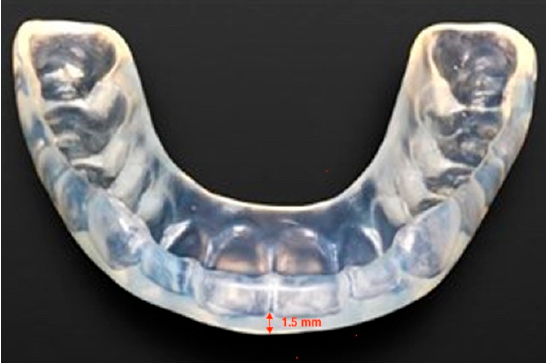
Figure 1. Individualized 1.5 mm thick occlusal appliance, made of a heat-cured acrylic resin (Duran ® , Scheu-Dental Technology, Iserlohn,